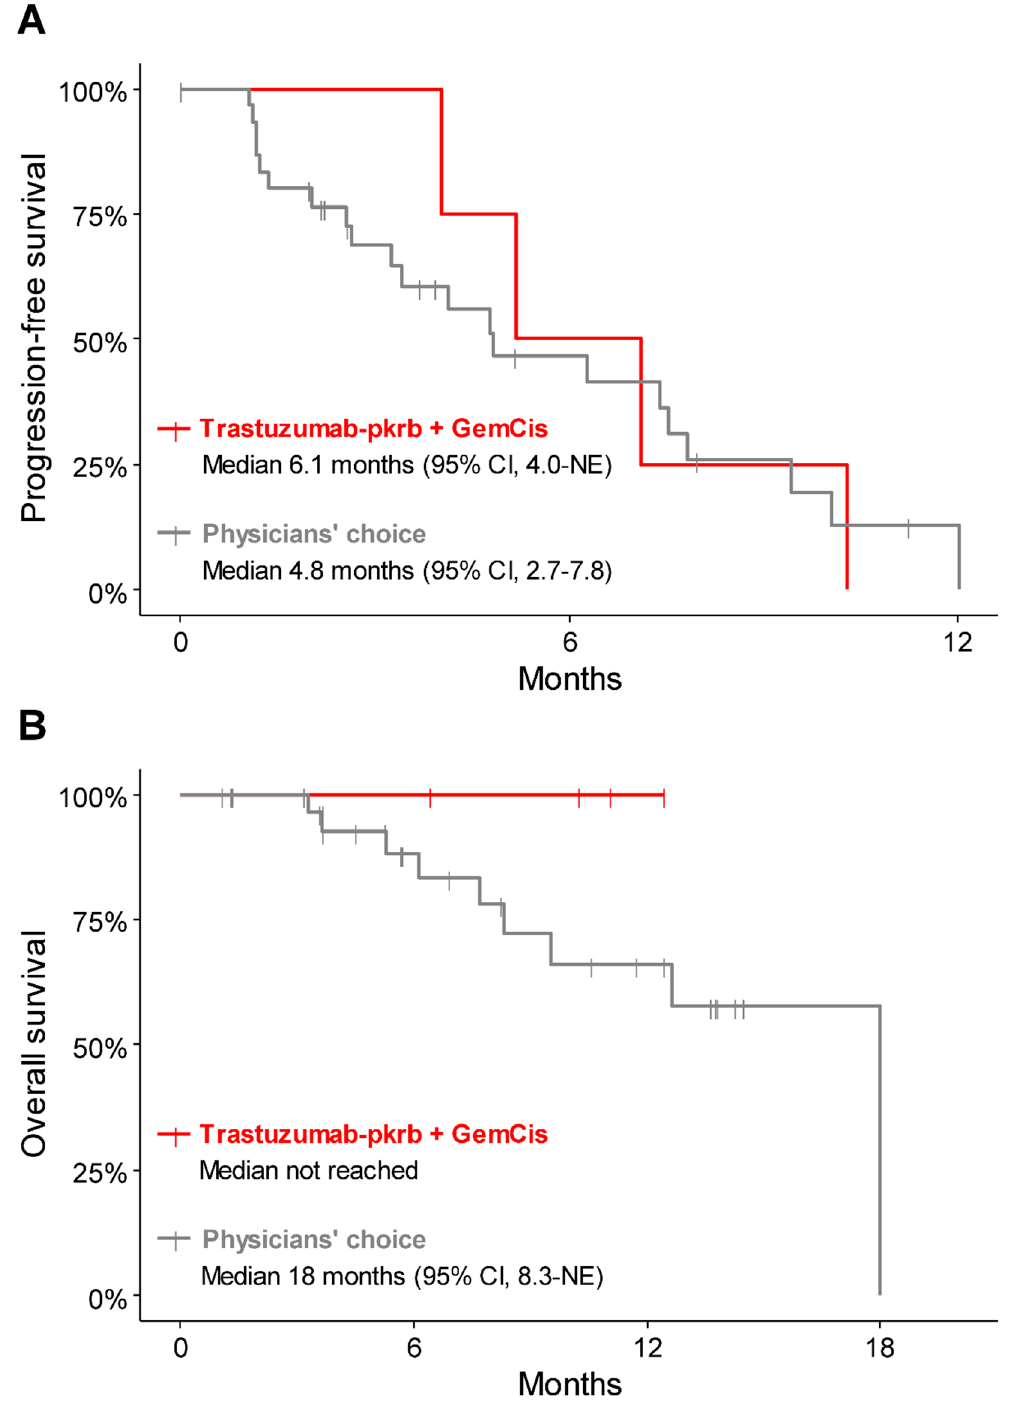
Figure 2. Kaplan–Meier survival curve for patients treated with trastuzumab-pkrb + GemCis and physicians’ choice of chemotherapy. ( A ) progression-free survival, ( B ) overall survival. Abbreviations: GemCis, gemcitabine and cisplatin.